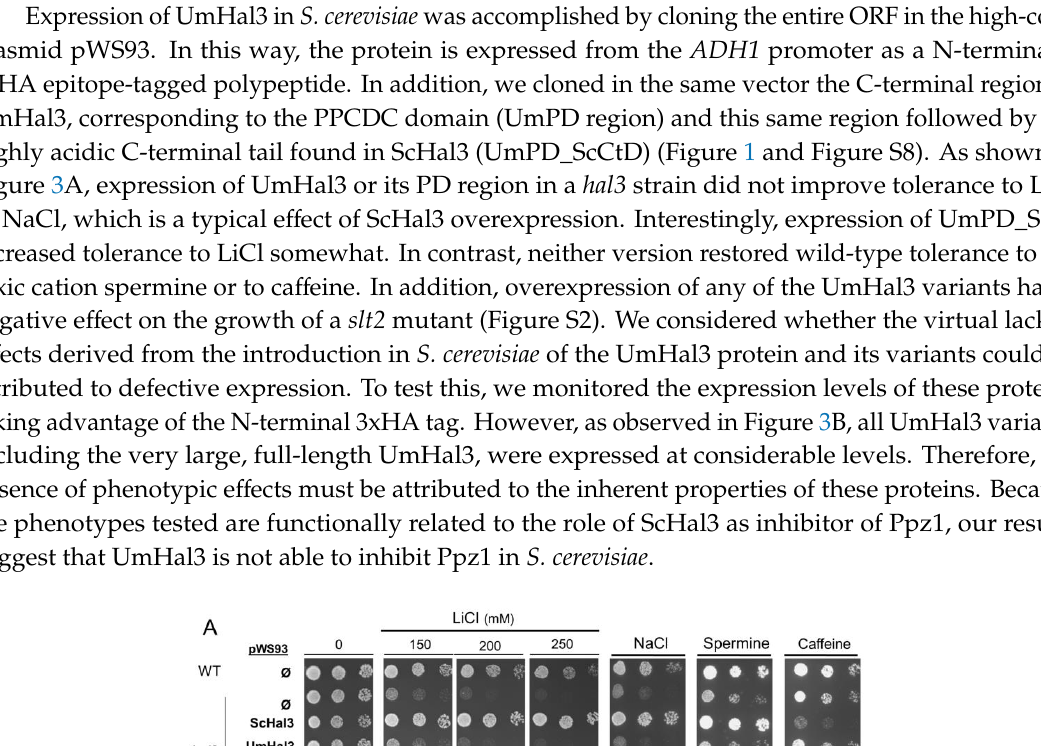
proteins were detected with anti-HA antibodies (indicated by arrowheads). Ponceau staining of the membranes is